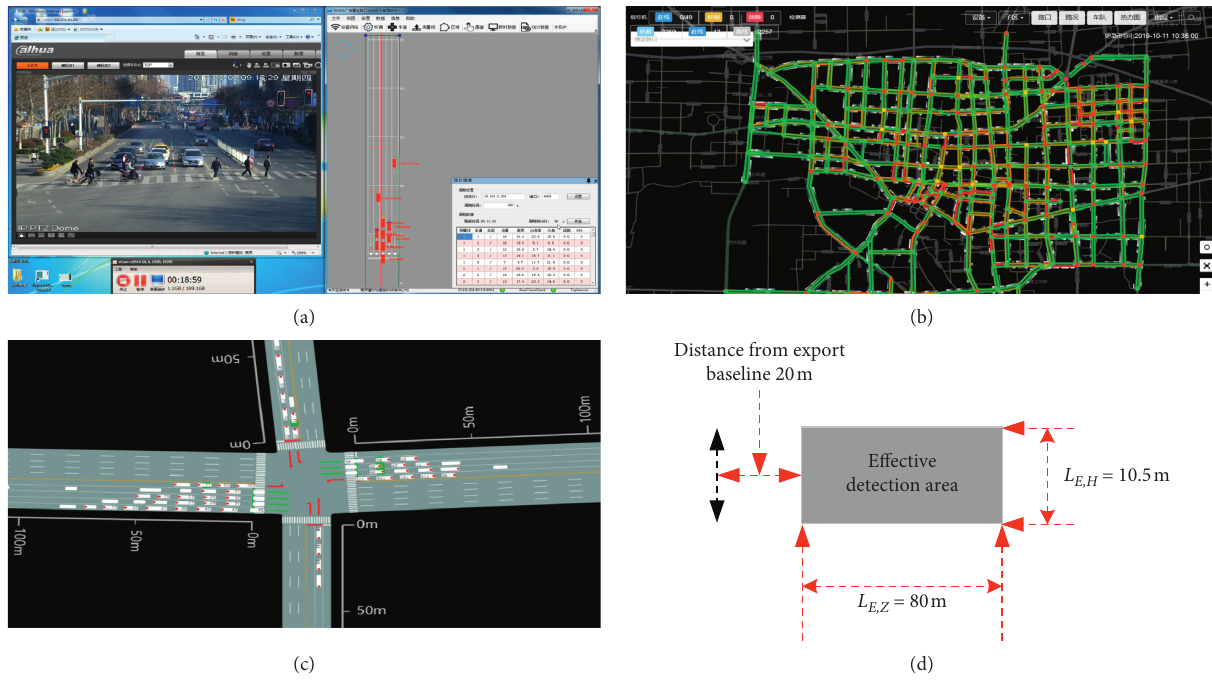
Figure 8: Intersection of Siping Road and Shengli Street in Weifang. (a) Wide-area radar detector setup software. (b) Middle- and microsimulation platform. (c) Signalized intersection. (d) Effective overflow detection